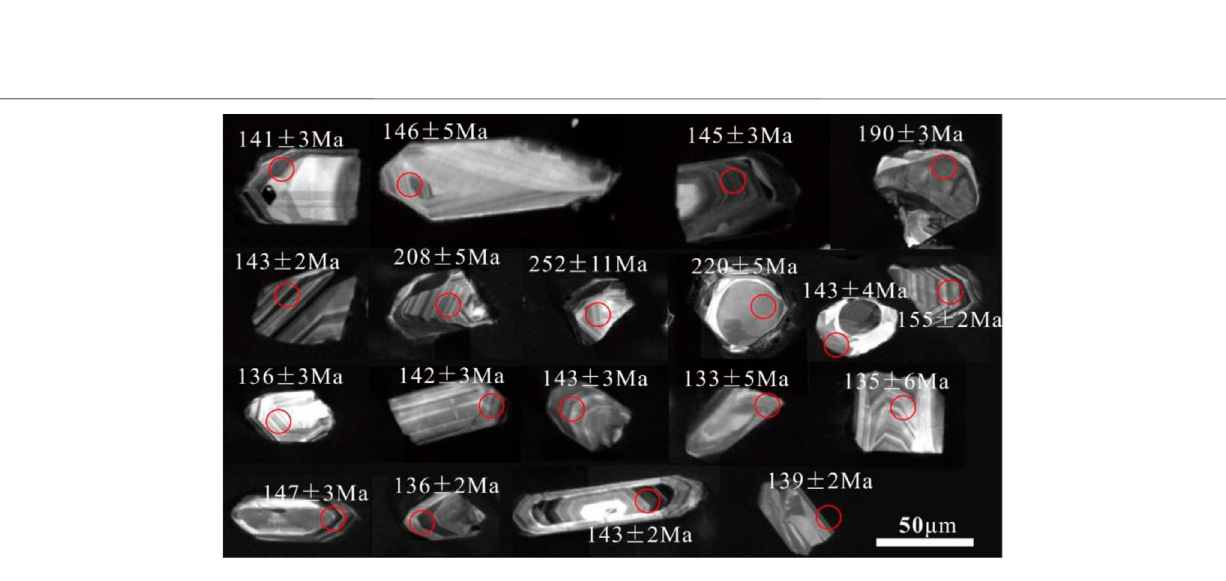
Frontiers in Earth Science |